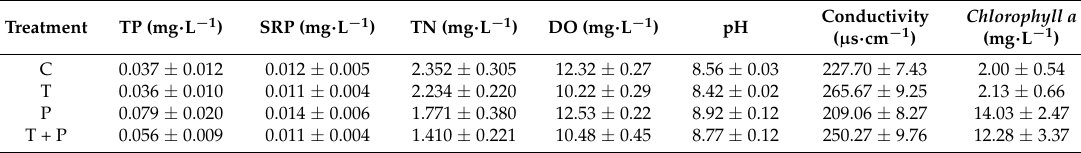
Table 1. Physicochemical characteristics concentrations in water of all the treatments in 2014. Values are Mean ± standard error (SE). Abbreviations used: control, C; water temperature was increased 4.5 °C compared with the control, T; addition of 50 μ g L − 1 phosphate every 2 weeks, P; addition of 50 μ g L − 1 phosphate every 2 weeks and temperature increase of 4.5 °C, T + P.